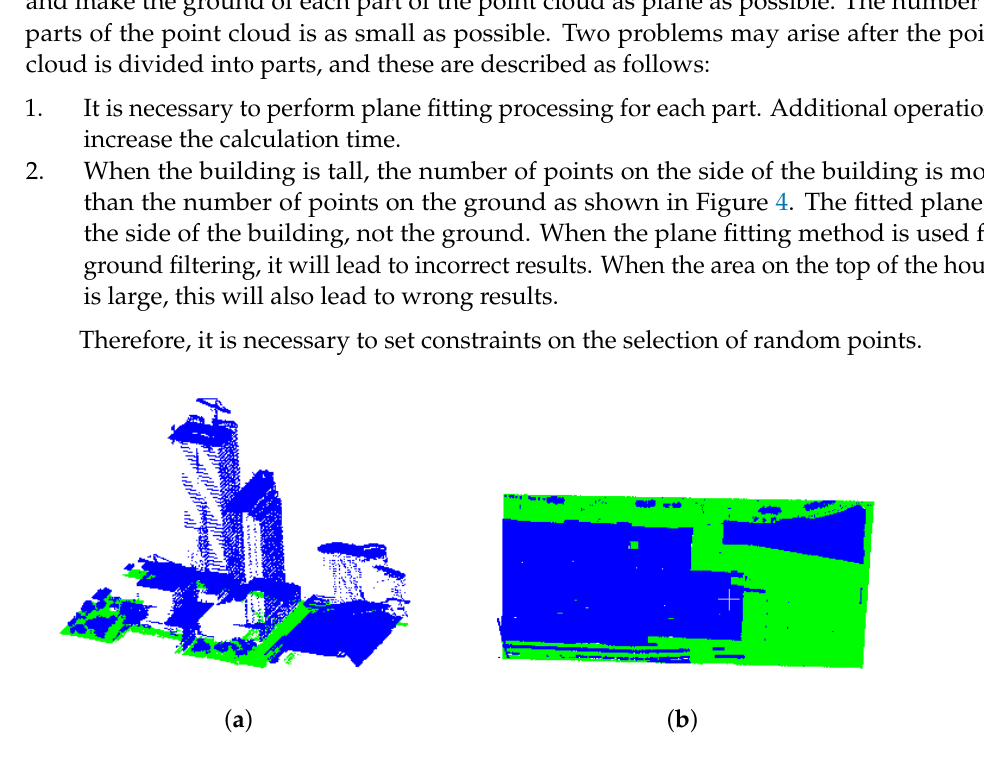
Figure 4. Special cases. The green points are ground points, and the blue points are non-ground points. ( a ) The number of points on the side of the building is greater than the points on the ground. ( b ) The number of points on the top of the building is greater than the points on the